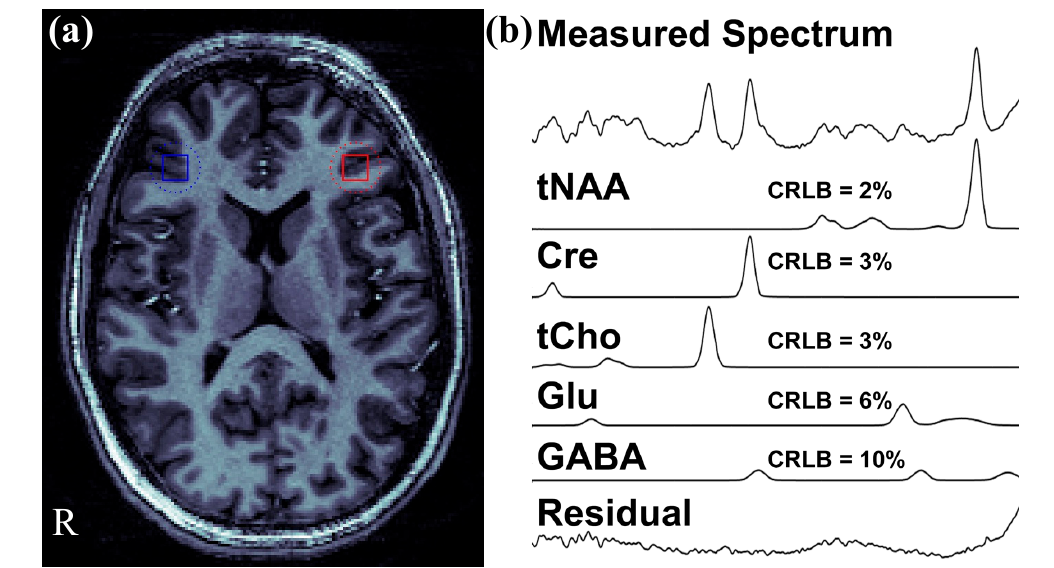
Figure 3. ( a ) Representative location for the right dorsolateral prefrontal cortex (DLPFC) (blue square) and the left DLPFC (red square) of a first episode schizophrenia (FES) patient. ( b ) Individual fits for the major compounds of interest, their Cramer–Rao lower bound (CRLB) values and a residual (a difference between the measured and fitted spectra) of magnetic resonance spectroscopic imaging (MRSI) spectrum of the right DLPFC region of interest (presented in part a ).